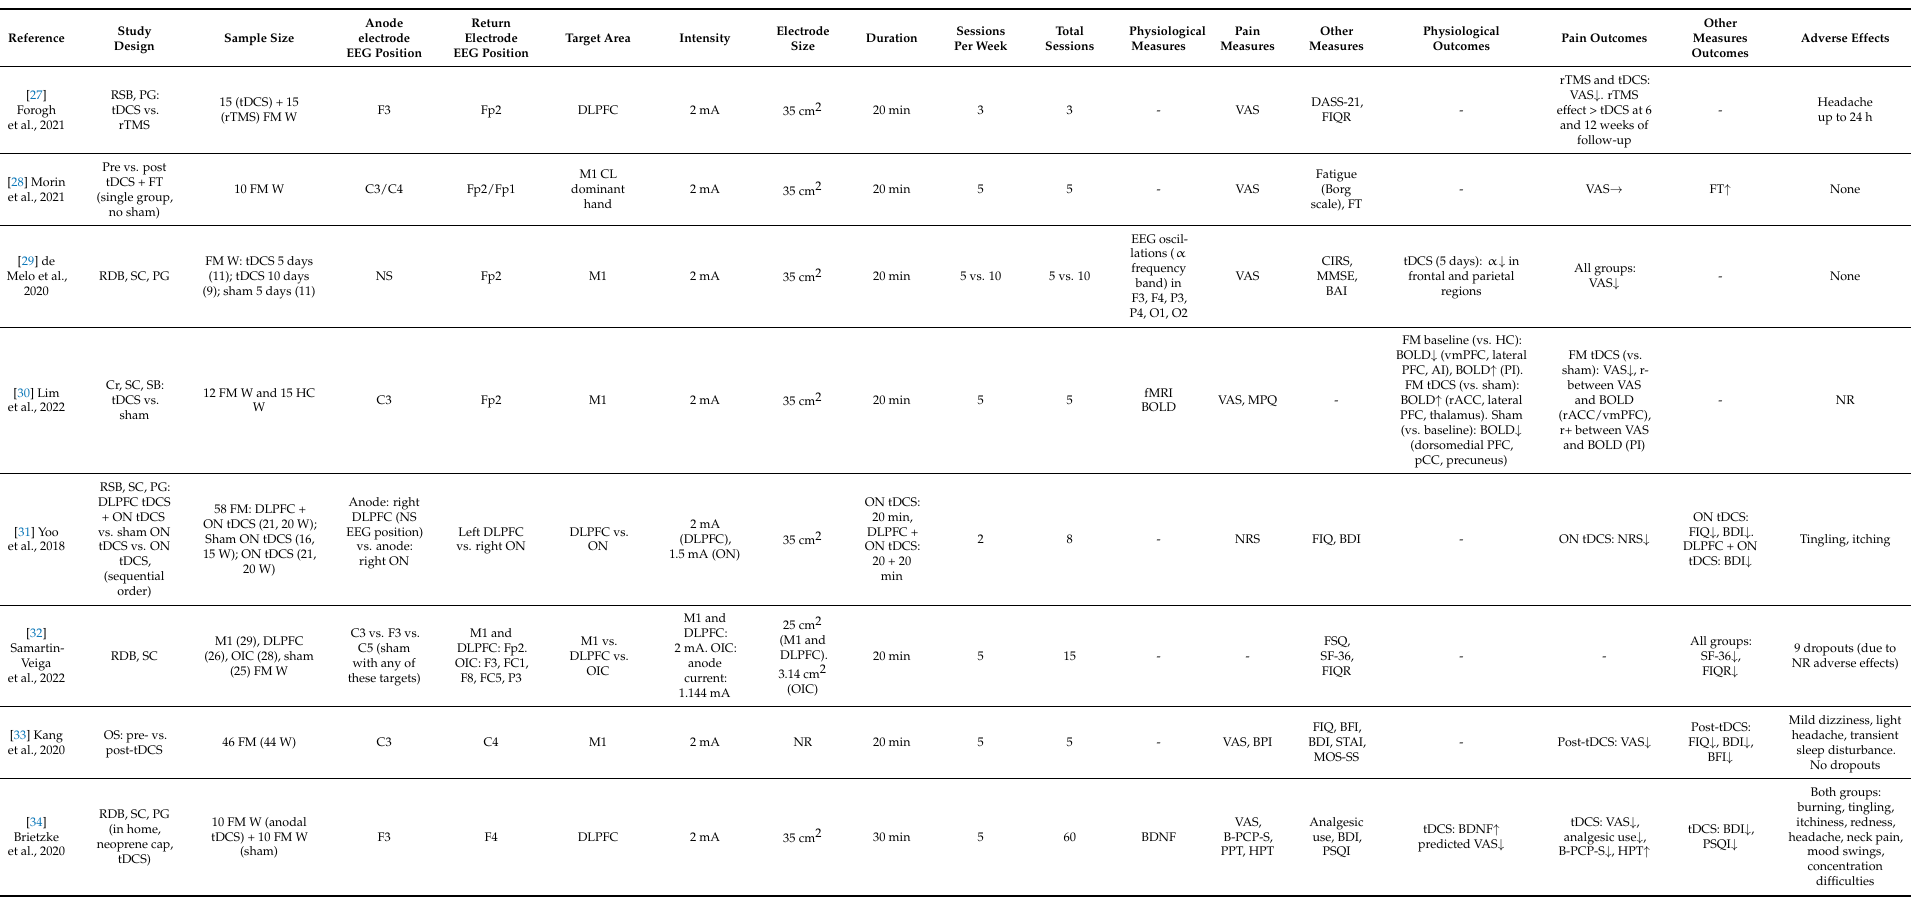
Table 3. Transcranial direct current stimulation (tDCS) protocols and results of relevant studies conducted to explore the neuromodulation effect on fibromyalgia